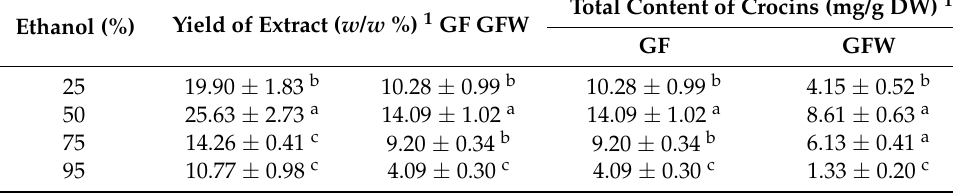
Table 2. The extractability and total content of crocins from the dried gardenia fruit (GF) and gardenia fruit waste (GFW).